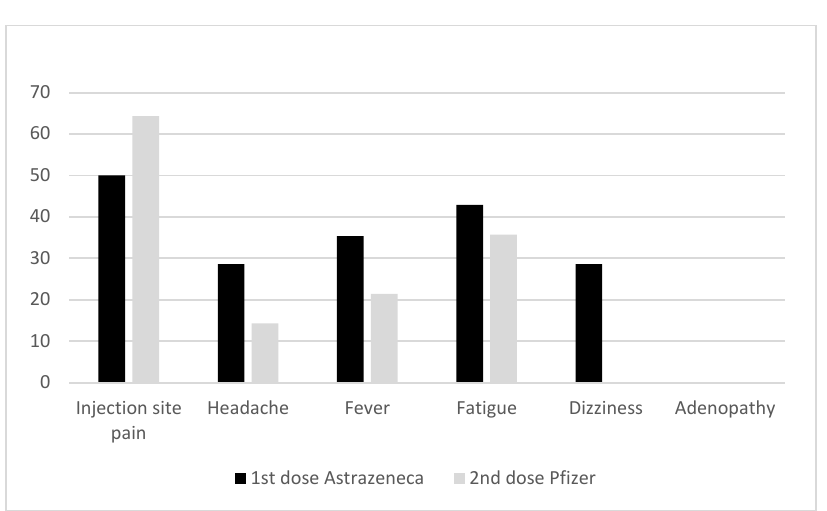
Figure 3. Adverse effects among participants with homologous vaccination.